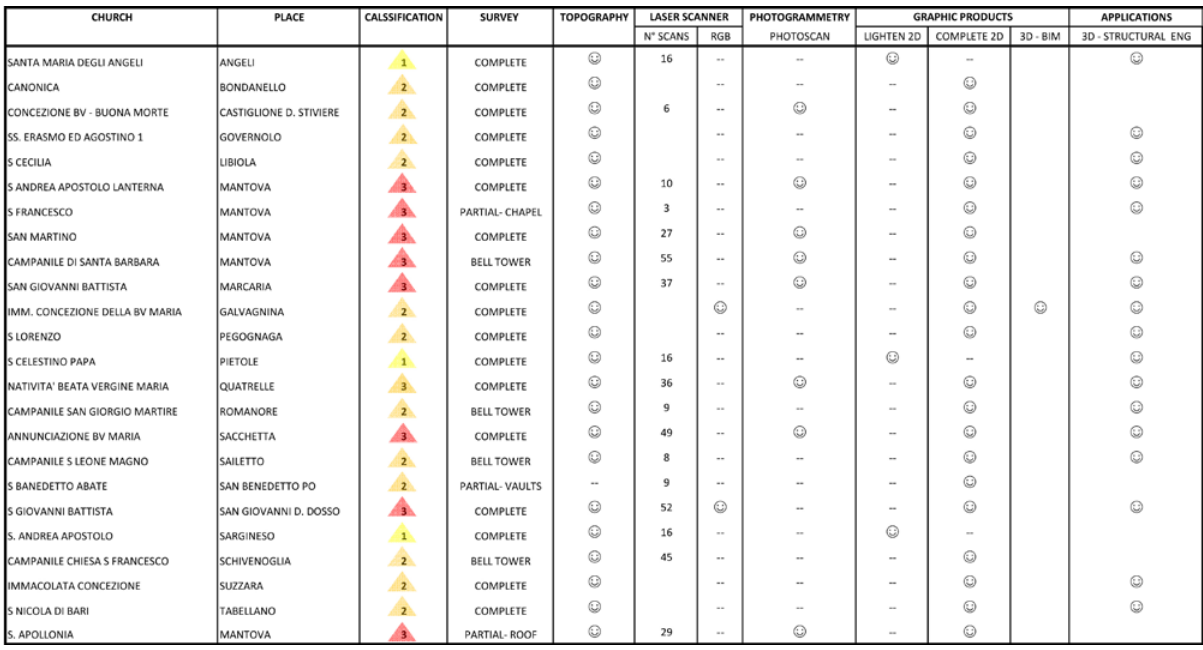
Table 1. Classification of survey